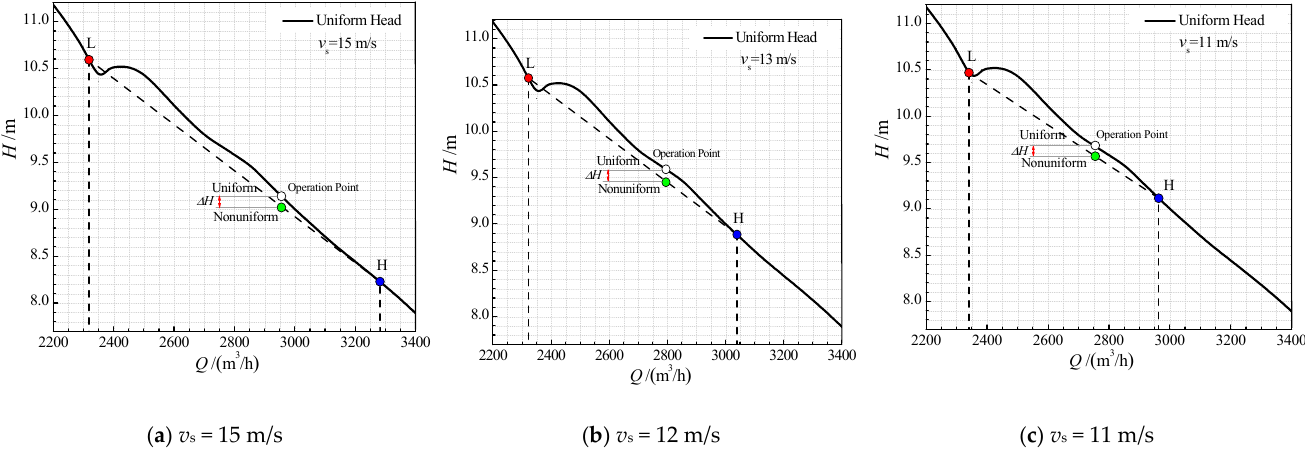
Figure 8. Operating point comparison between tube L and H, at partial deep stall condition.